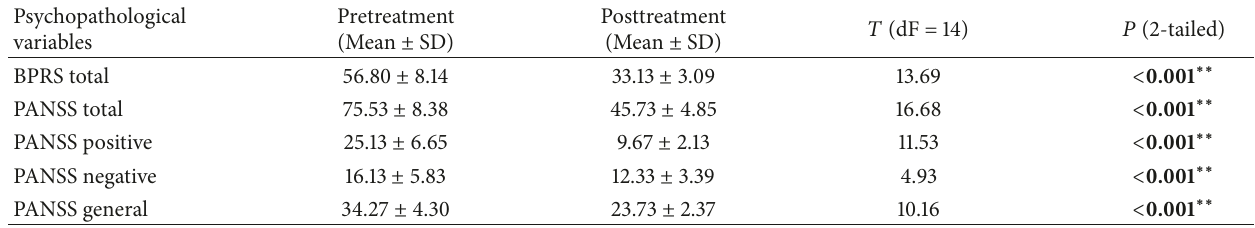
Table 2: Comparison between pre- and posttreatment psychopathological scores ( 𝑁 = 15 ).